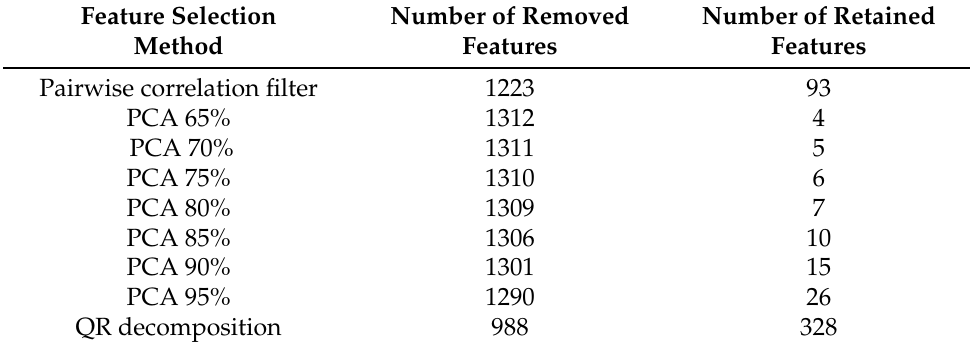
Table 1. Number of removed and retained features after the implementation of the pairwise correla- tion filter, Principal component analysis (PCA) with feature set variance ranging from 65% to 95%, and QR